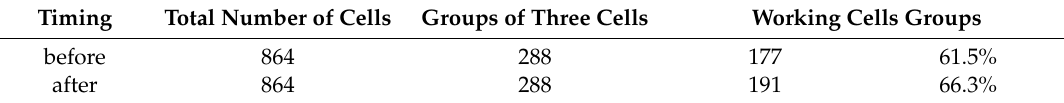
Table 6. Condition of the photocells before and after dehumidification. Timing Total Number of Cells Working Cells before 864 after Table 7. Real condition of the cells, with bypass diodes, before and after dehumidification. Timing Total Number of Cells Groups of Three Cells Working Cells Groups before 864 288 177 61.5% after 864 288 191